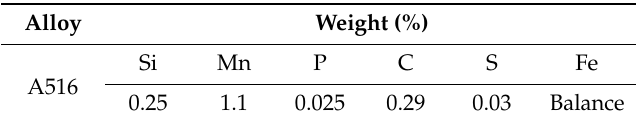
Table 3. Chemical composition of carbon steel A516.